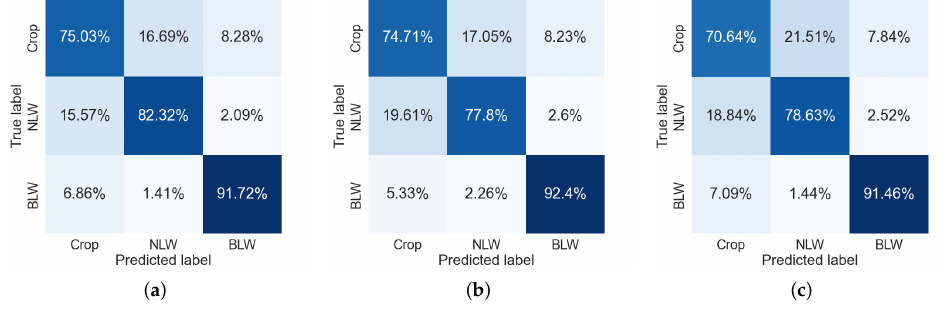
Figure 13. Confusion matrices of the three SVM models. ( a ) SVM A . ( b ) SVM B . ( c ) SVM C .